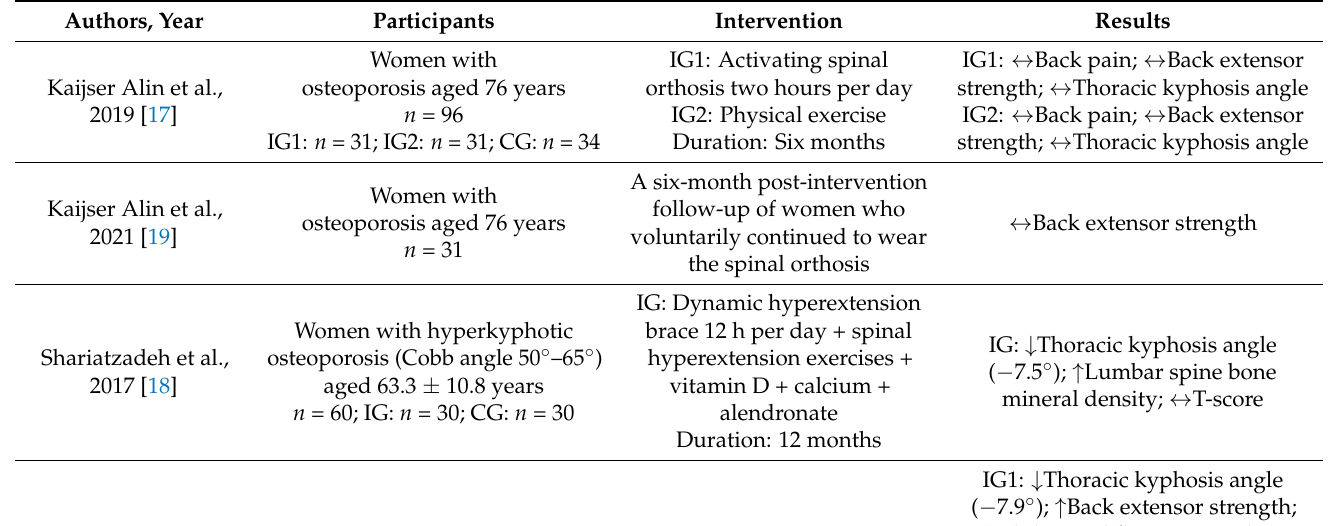
Table 1. Participants demographics, outcomes assessed, intervention characteristics, and results of included